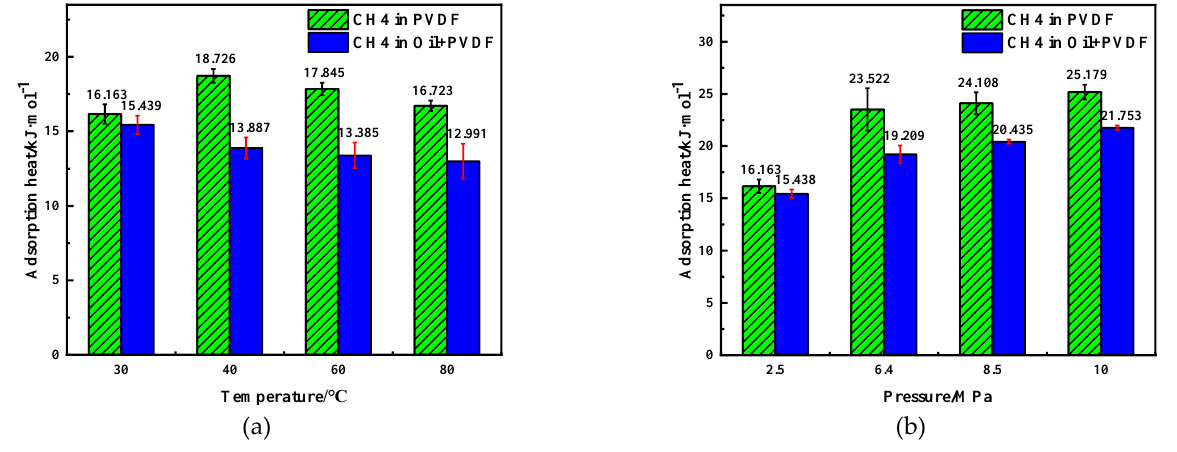
Figure 6. Isosteric heat of adsorption of CH 4 in PVDF at different conditions: ( a ) 2.5MPa; ( b ) 30 °C.